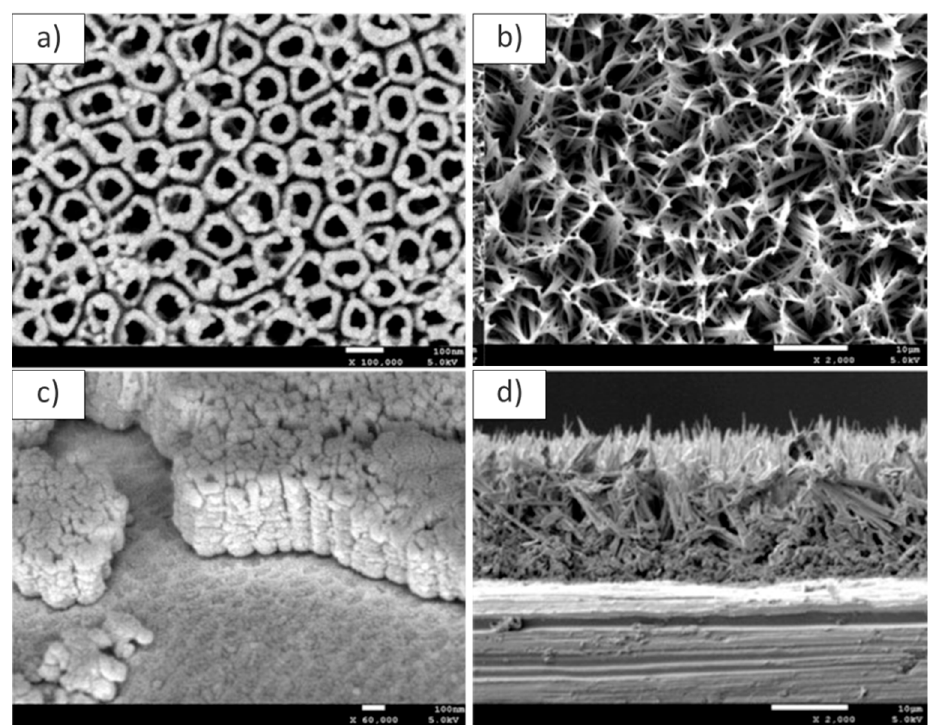
Figure 4. ( a ) FESEM image of TiO 2 nanotubes and ( b ) GelGOHA composite coating on titanium. ( c ) Cross-section of TiO 2 nanotubes and ( d ) GelGOHA coating on titanium. (Reprinted with permission from [40], Elsevier 2015 copyright n. 4710121336953).